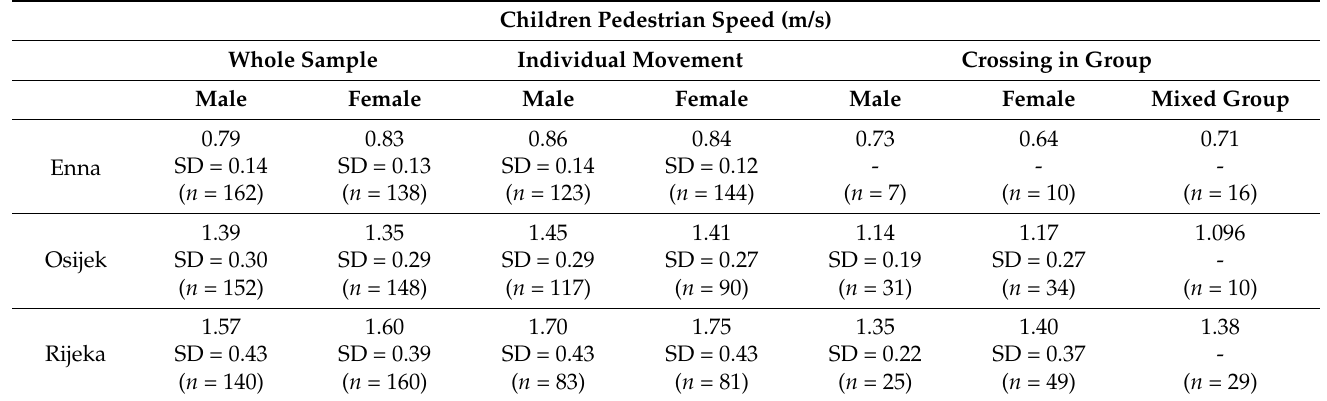
Table 6. Children pedestrians’ speed–depending on gender and walking in a group.